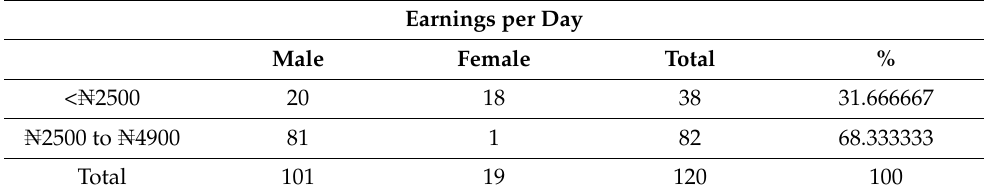
Table 5. Earnings of waste pickers in Lagos State, Nigeria.